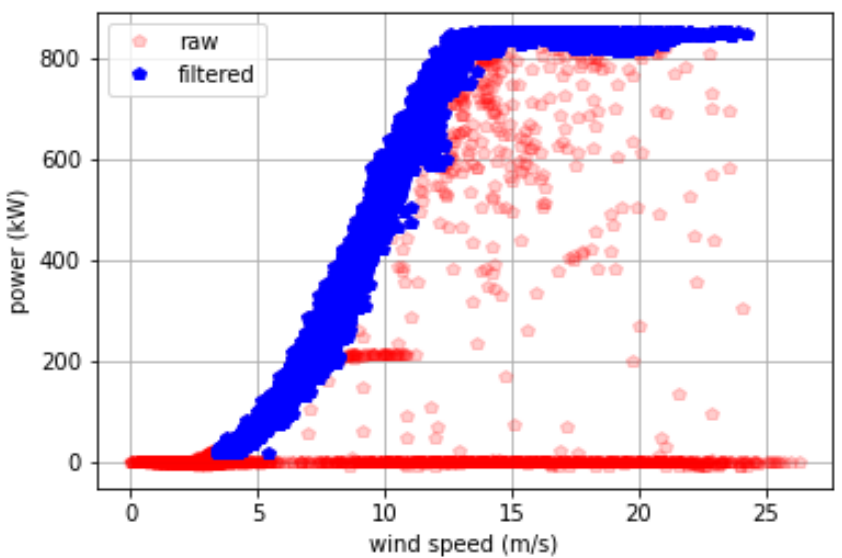
Figure 1. Effect of data clustering though the Random Forest algorithm: Tar wind turbine.